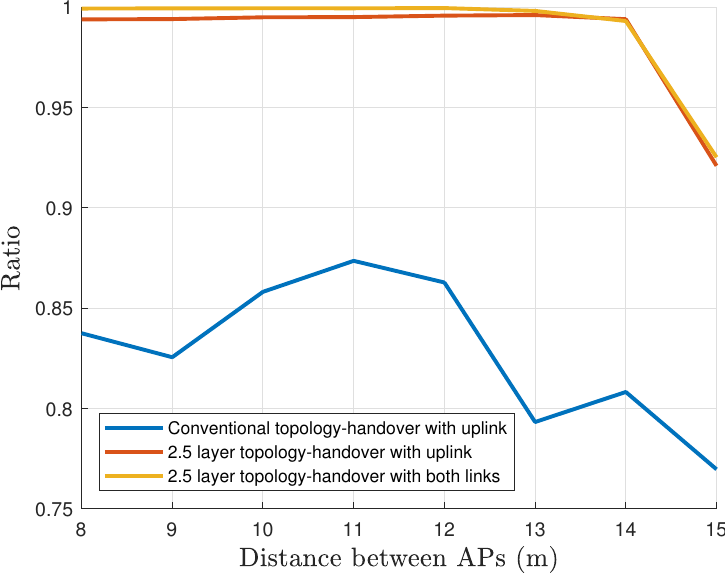
Figure 16. Service availability comparison with single